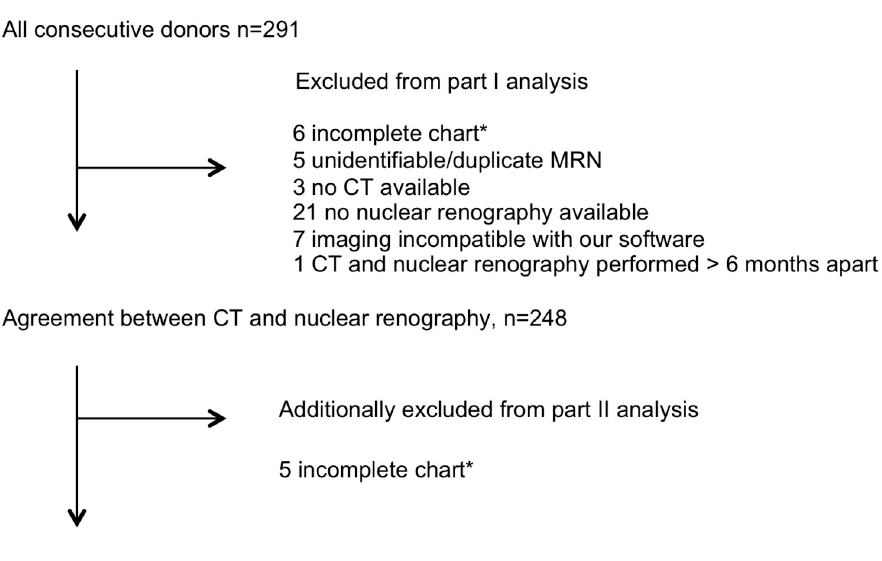
Fig 1. Study recruitment. � Incomplete defined as no available serum creatinine, date of donation, or follow up visits. CT, computed tomography.